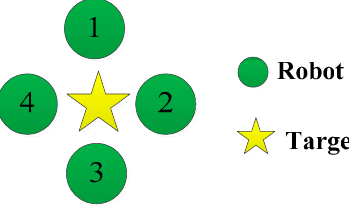
Figure 2. Target is hunted by AUVs.